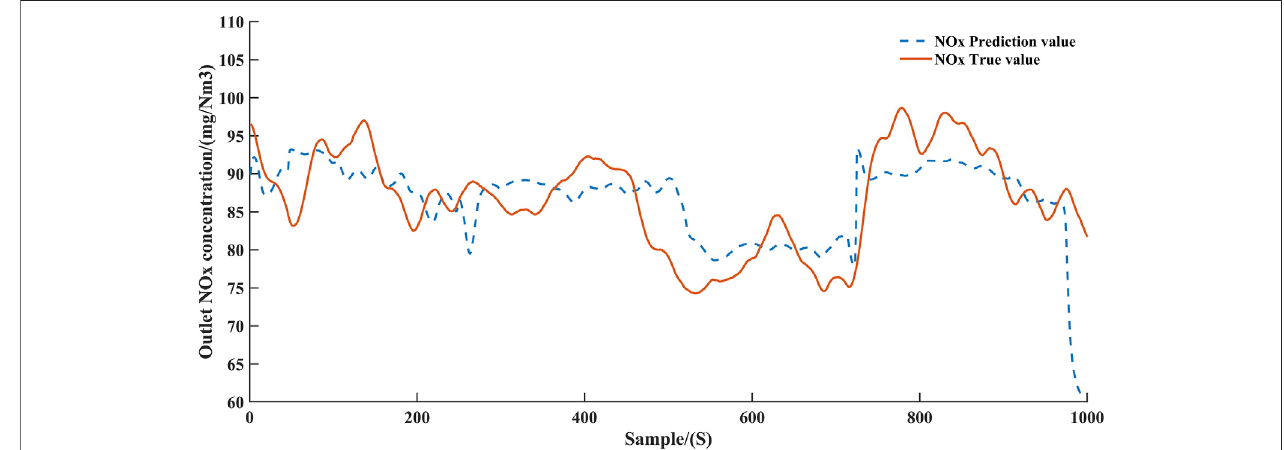
FIGURE 7 | NOx concentration prediction curve after parameter freezing training.